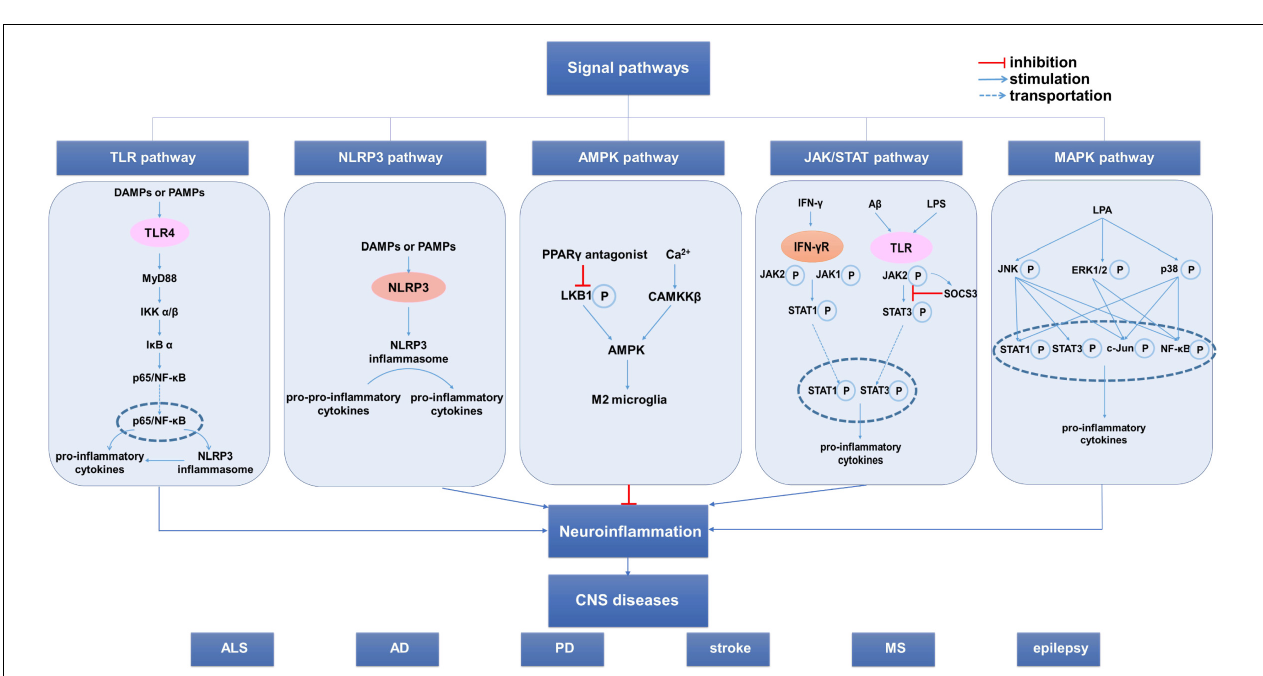
FIGURE 2 | The modulators involved in the microglia phenotypic transition. Various modulators can regulate M1/M2 microglia phenotypic transition. This figure is summarized by classification of different modulators. CNS, central nervous system; ROS, reactive oxygen species; TREM2, trigger receptor expressed on myeloid cells 2; CX3CR1, C-X3-C motif ligand 1 receptor.